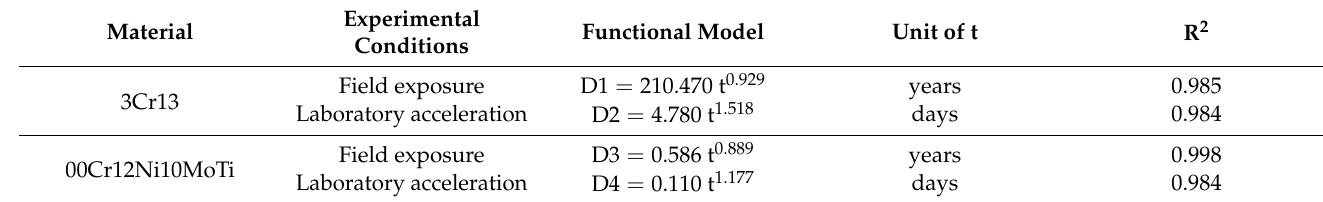
Table 6. Corrosion kinetic equations of two stainless steels.